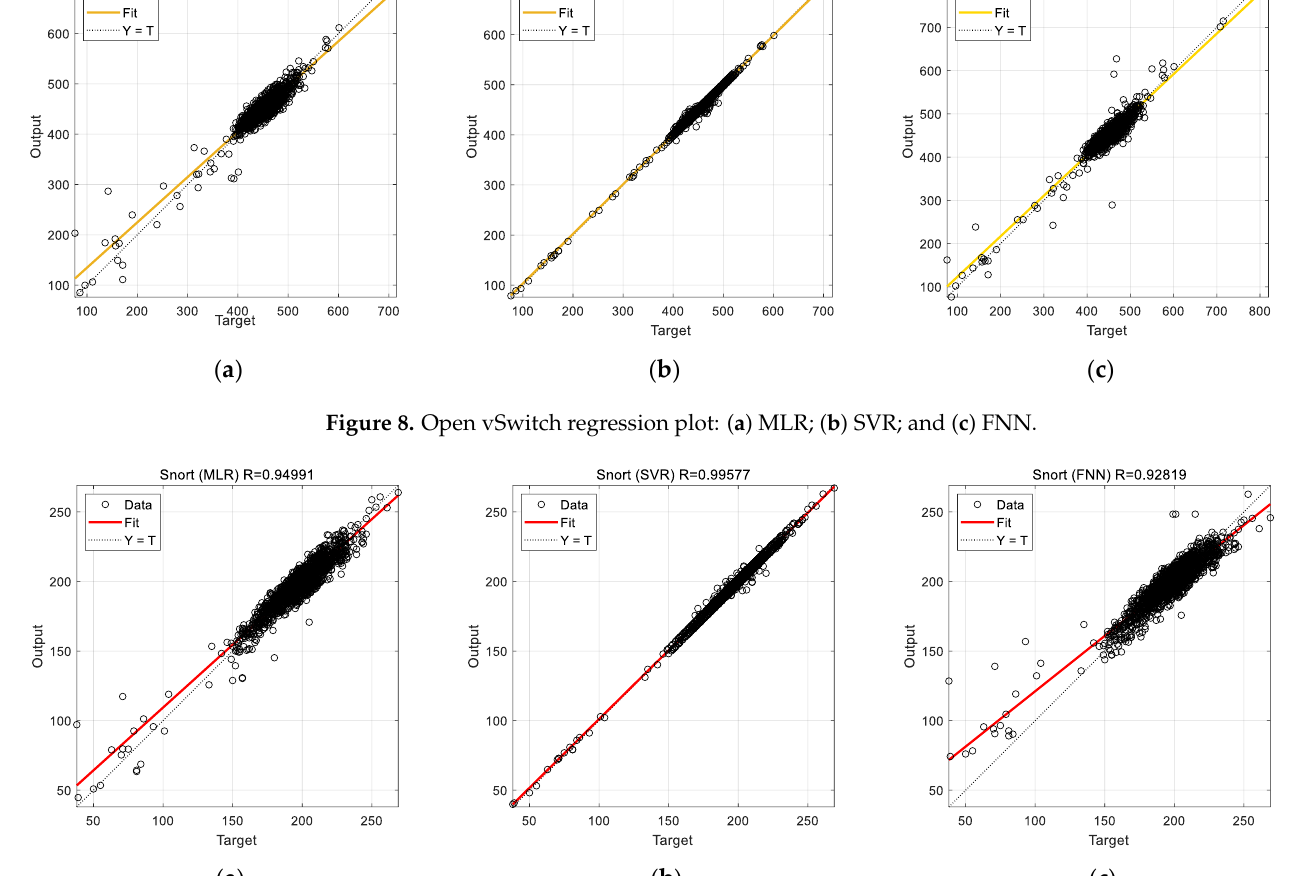
Figure 9. Snort regression plot: ( a ) MLR; ( b ) SVR; and ( c ) FNN. Table 1. The correlation factor 𝑅 of all the results from Figures 7 – 9.